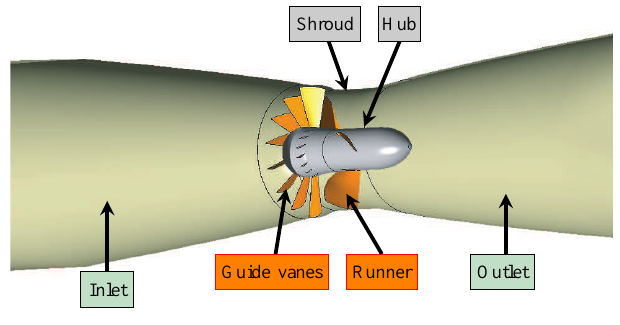
Fig. 3. Cross section through the turbine geometry shown in